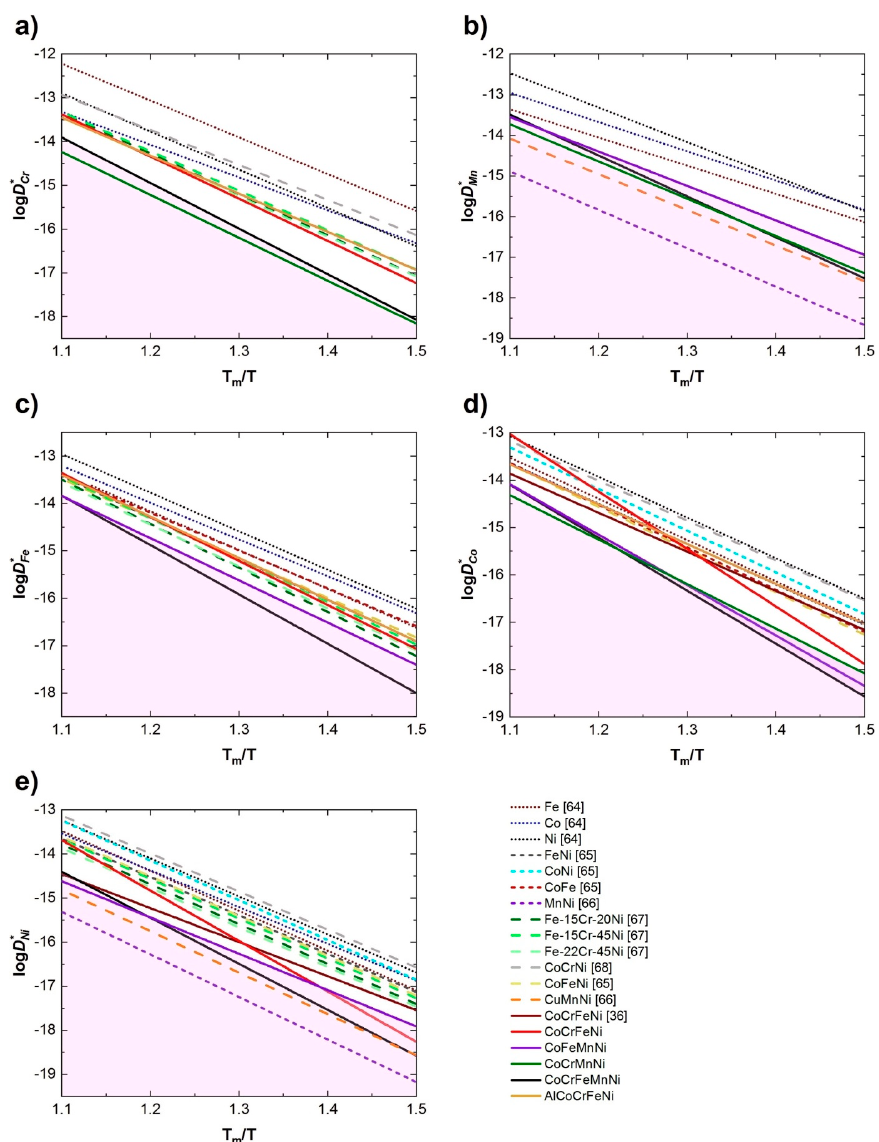
Figure 28. Tracer diffusion coefficients of different elements in different FCC matrices: ( a ) Cr, ( b ) Mn, ( c ) Fe, ( d ) Co, ( e ) Ni. All plots are presented in temperature scale, normalized with respect to melting points of the alloys. The colored area is limited by the fastest diffusing Mn-containing system [45]. Reprinted from Journal of Alloys and Compounds 783 (2019), Demystifying the sluggish diffusion effect in high entropy alloys, 193–207, Copyright 2019, with permission from Elsevier.